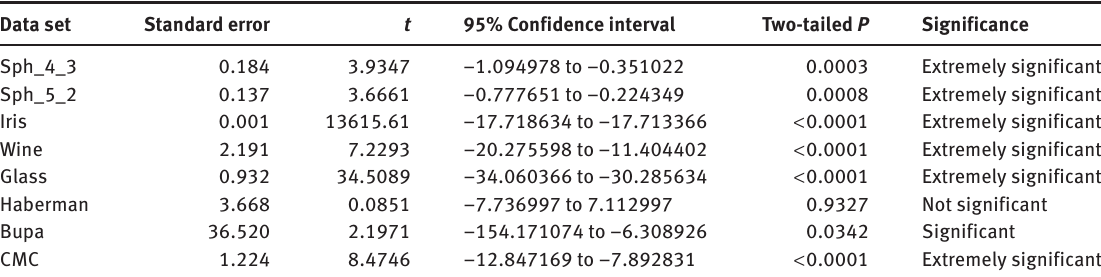
Table 11: Unpaired t Test Between the Best and the Second Best Performing Algorithms for Each Data Set Based on the Sum of Intracluster Distances.